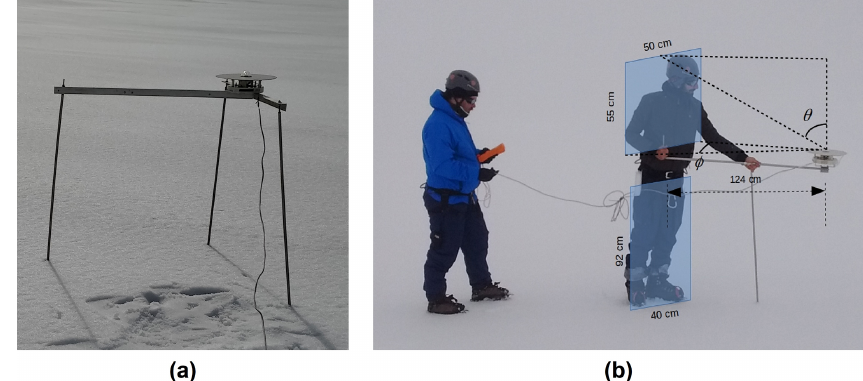
Figure 3. Albedo measurement equipment. (a) Mounting stand used in the 2016 campaign. (b) Mounting stand used in the 2017 campaign. The presence of the stand and the observer is taken into account to correct the albedo measurement through the angles θ and φ and Eqs. (S1) and (S2) in the Supplement.